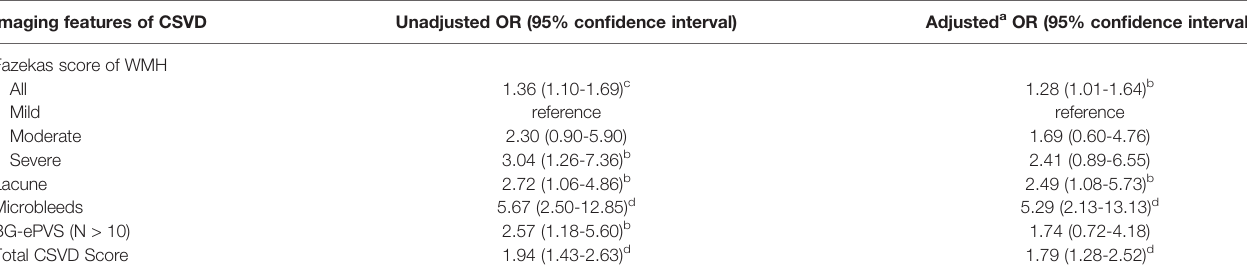
TABLE 2 | Association between MRI features and cognitive